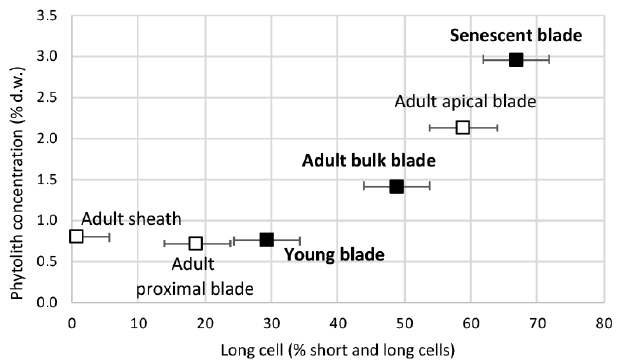
Figure 2. Growth chamber experiment 1: Phytolith concentration vs. long cell phytolith proportion. Error bars represent the 5% error on counting (refer to text for